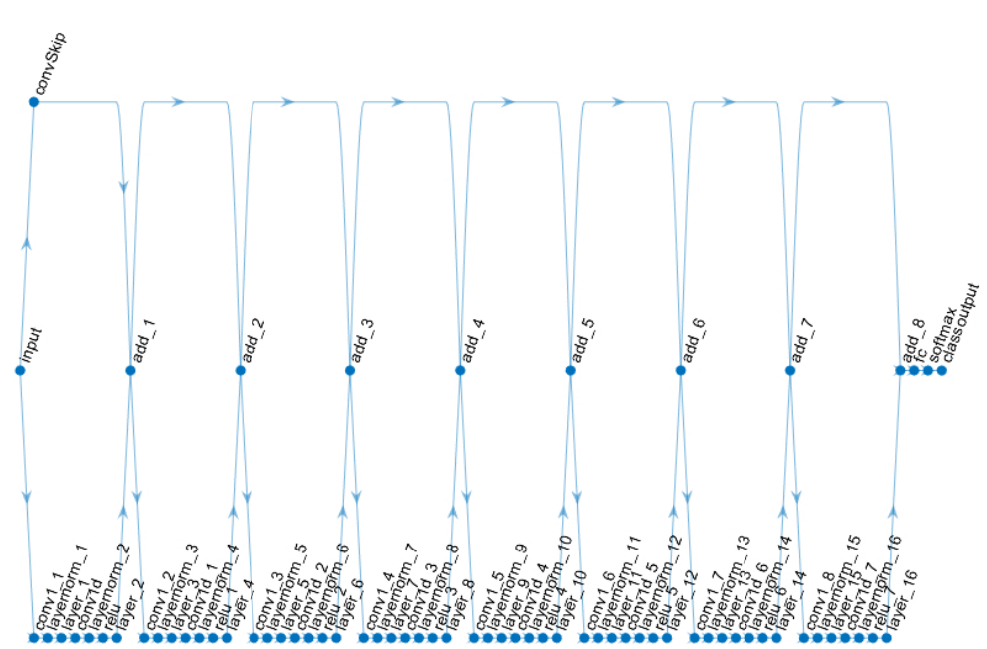
Figure 10. The CNN model for Data-Fusion-Centric